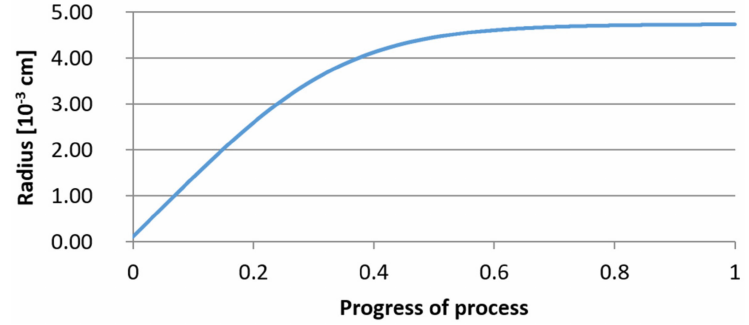
Figure 14. Increase of nucleus radius (initial radius r 0 = 1 µ m) in steel